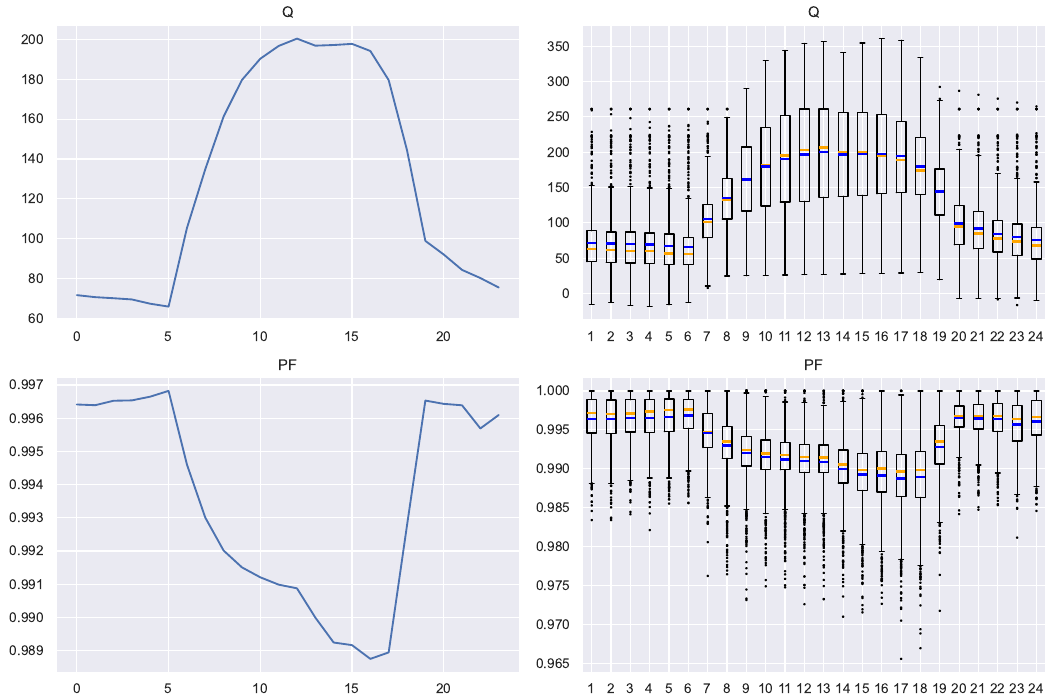
Figure 15. Average profile and box plots of the extended variables in Scenario A. Blue: mean. Orange: median.